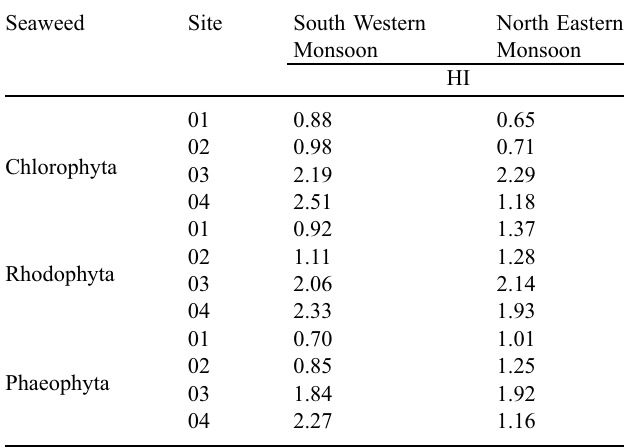
Table 6. Hazard index for sample seaweed classes from identi fi ed areas of Sri